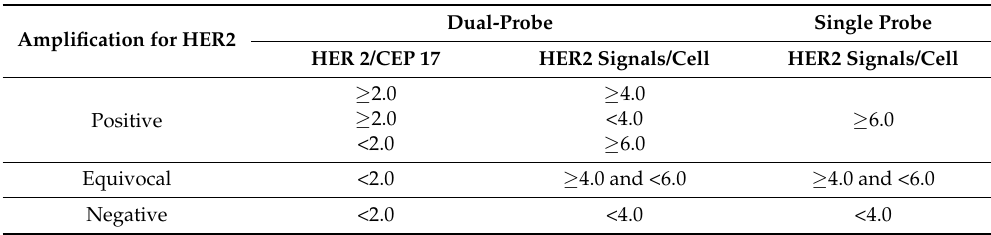
Table 2. Recommended reporting of FISH results